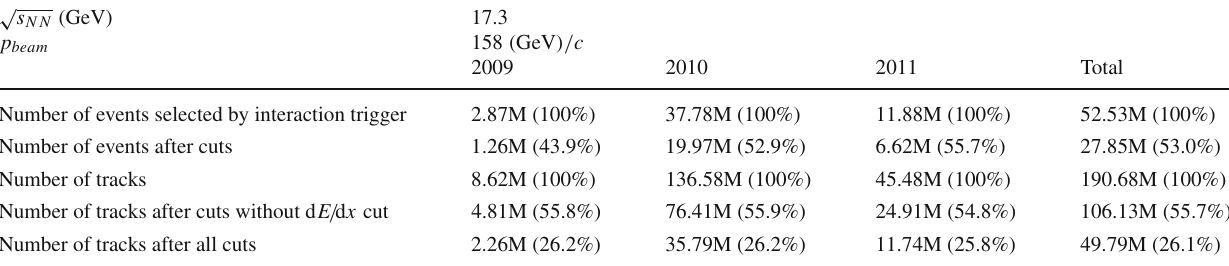
Table 1 Data sets used for the analysis of K ∗ ( 892 ) 0 production. The same event and track cuts (Sects. 3.3, 3.4 and 3.5) were used for all three data taking periods √ s NN